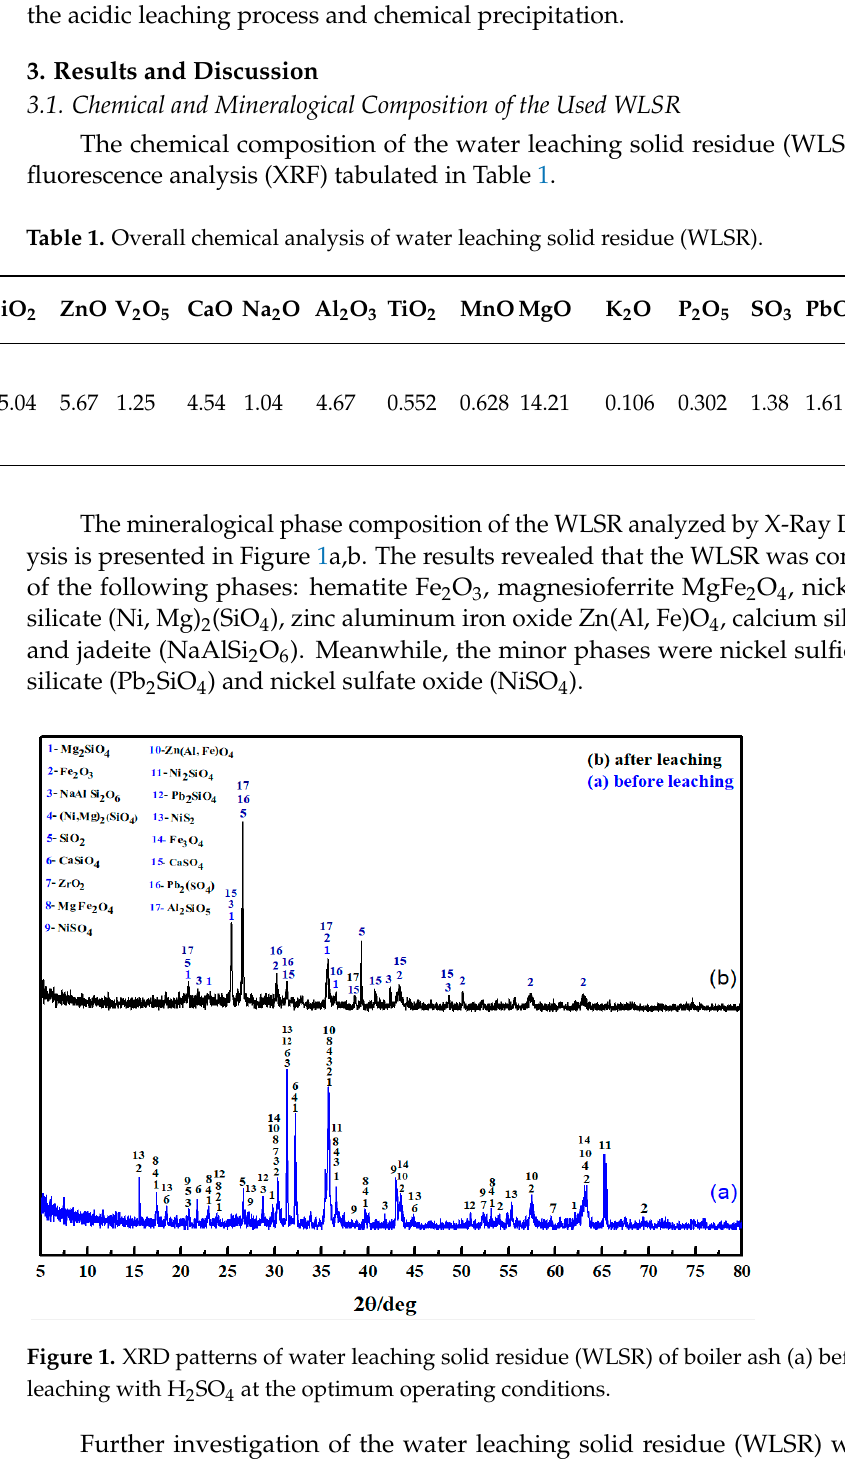
Figure 2. SEM images of used water leaching solid residue (WLSR) obtained under optimum leaching conditions of the Egyptian boiler ash ( A ) and EDX element analysis ( B ). 3.2. Thermodynamics Analysis of Leaching Process The reactions of the components in WLSR with H 2 SO 4 according to Equations (3)–(14) are presented in the thermodynamic diagrams (Figure 3). The original crystal structure of the residue has been totally changed by means of sulfuric acid leaching. The metallic components such as iron, zinc, nickel and magnesium in the WLSR were converted into the corresponding sulfate and leached by the sulfuric acid solution; on the other hand, calcium, lead and silicon were converted into lead sulfate (PbSO 4 ), calcium sulfate (CaSO 4 ) precipitate and metasilicic acid (H 2 SiO 3 ) as colloidal precipitate, respectively. The ther- modynamic results shown in Figure 3 illustrate the feasibility of this method for leaching water leaching solid residue (WLSR) with sulfuric acid to obtain dissolved metal sulfate because the Gibbs free energy change ( Δ G) of the above Equations (3)–(14) had negative